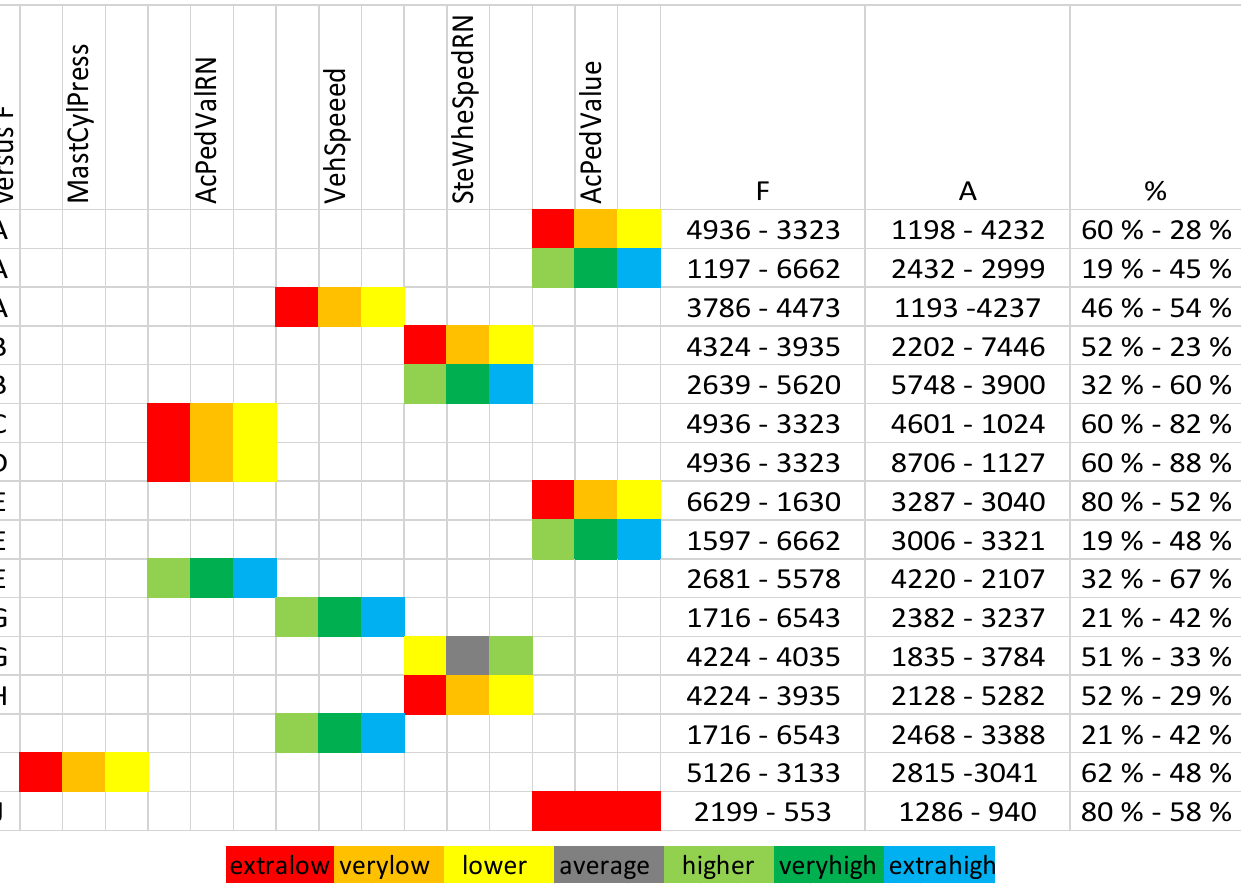
Figure 5. Hypotheses that distinguish driver F in pairs from other drivers